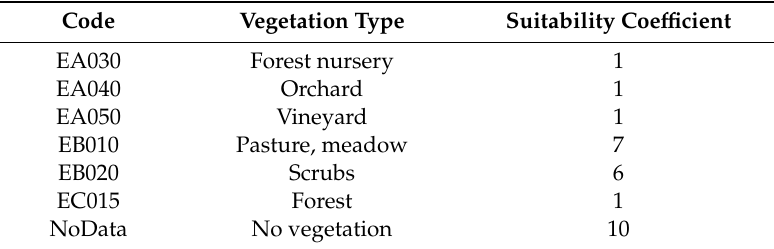
Table 6. Codes of vegetation types and their suitability for deployment of DS.